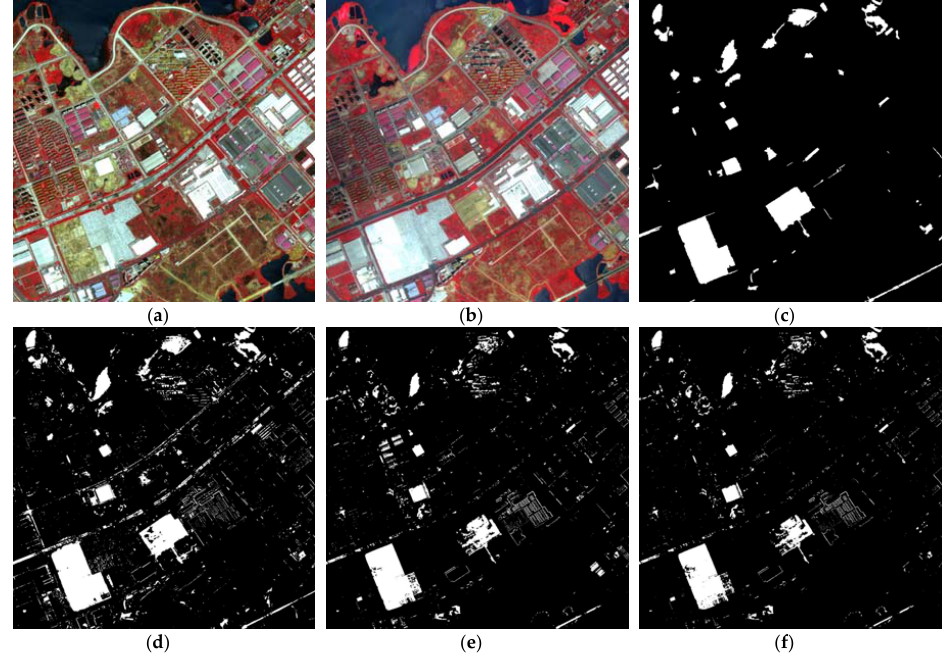
Figure 6. The zoomed multispectral images on ( a ) 11 April 2016; and ( b ) 1 September 2016; and the zoomed binary change maps of ( c ) the proposed method; ( d ) CVA; ( e ) IRMAD; and ( f ) ISFA.